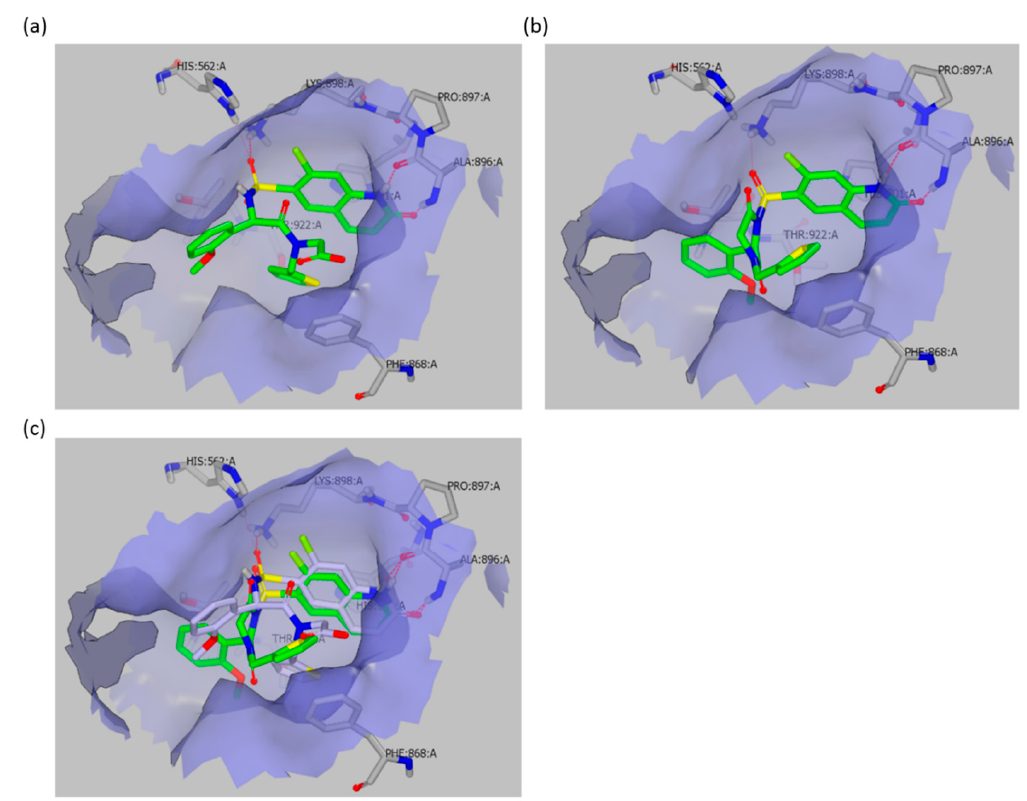
Figure 5. ( a ) Representation of the binding pose of OSMI-4a in OGT active site (PDB: 6MA1 10.2210/pdb6MA1/pdb); ( b ) predicted binding mode of OSMI-4 DKP in OGT active site. Docking was performed using FRED algorithm on OEDocking software (OEDOCKING 3.3.0.2: OpenEye Scientific Software, Santa Fe, NM, USA. http://www.eyesopen.com) (Materials and Methods); ( c ) representation of OSMI-4 DKP (green) and OSMI-4a (grey) overlapped in OGT binding pocket. Pictures prepared with Vida (VIDA, version 4.3.0.4, OpenEye Scientific Software, Inc., Santa Fe, NM, USA, www.eyesopen.com).